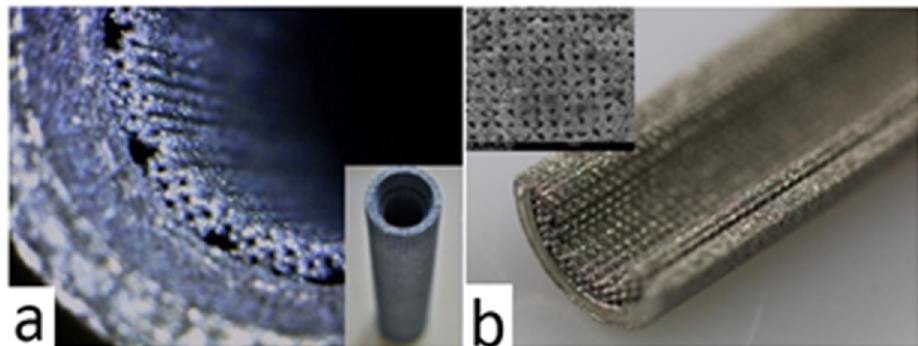
Figure 13. Additively manufactured heat pipes with an internal wick structure ( a ) Reprinted with permission from Ref. [84]. Copyright 2013 Elsevier and ( b ) Reprinted with permission from Ref. [88]. Copyright 2013